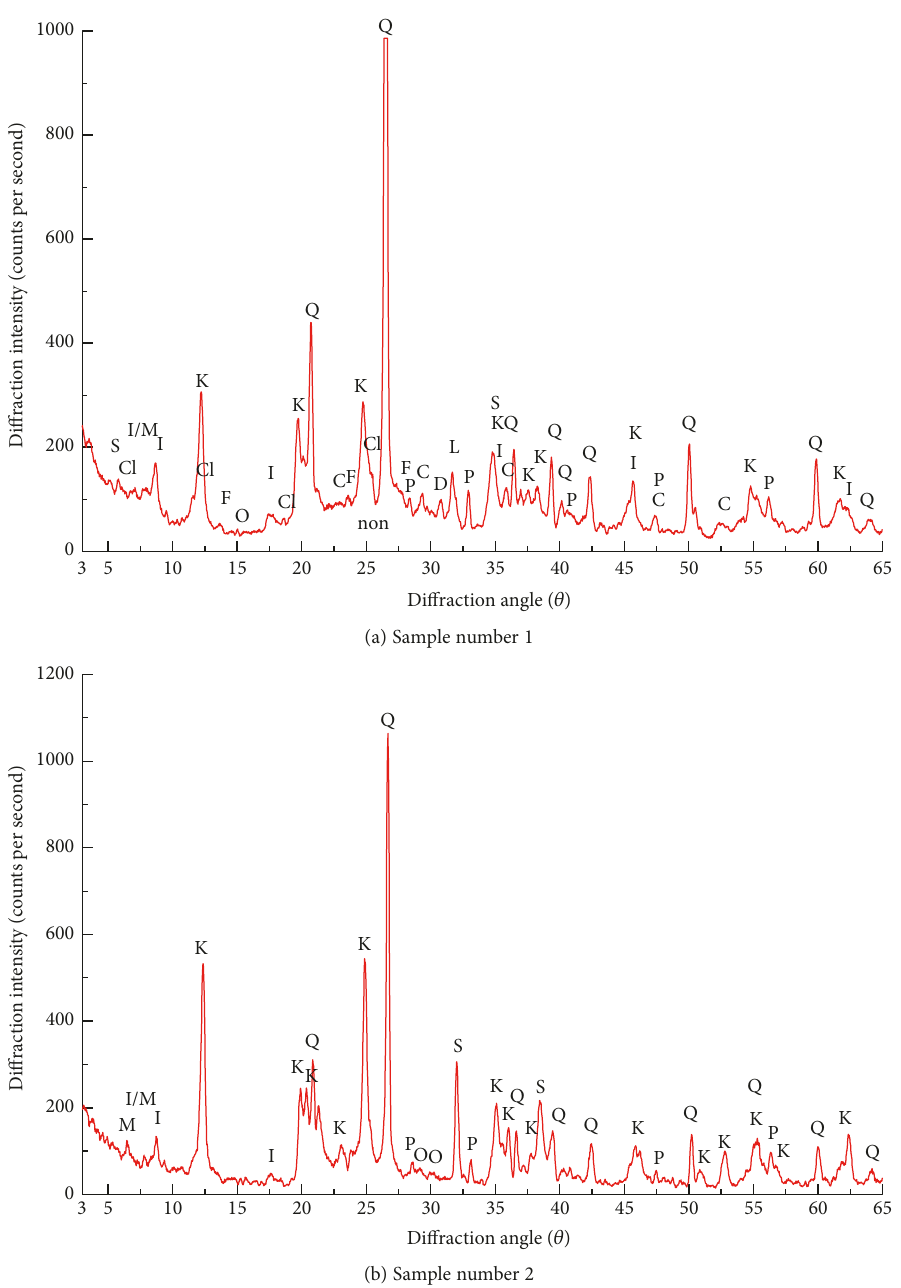
Figure 4: XRD patterns of the fresh coal gangue. (a) Q: quartz (high); K: kaolinite (high); I: illite; I/M: illite-montmorillonite mixed layer; Cl: Chlorite; S: Smectite; D: dolomite (low); P: pyrite; L: siderite; C: calcite (low); F: feldspar; non: amorphous materials; O: others (low). (b) K: kaolinite (high); Q: quartz (high); I: illite (high); I/M: illite-montmorillonite mixed layer; S: siderite; P: pyrite (low); O: others